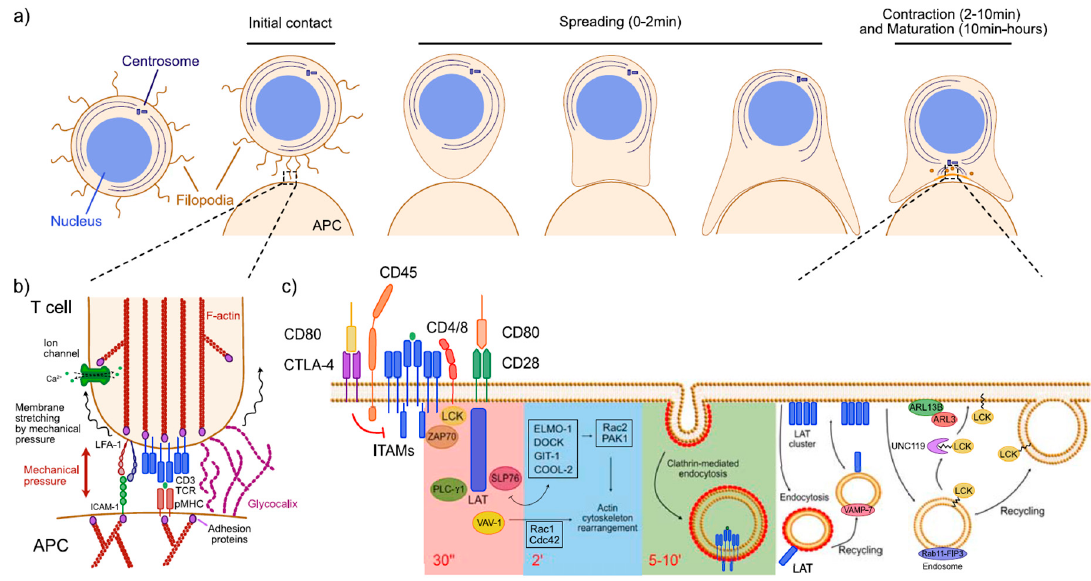
Figure 1. Temporal regulation of signaling during early T cell activation. ( a ) The schematic shows the stages of early T cell activation and immunological synapse formation (adapted from [19]). T cells scan their environment via filopodia sensing. After initial contact (that occurs within seconds), the T cell spreads rapidly, increasing the area of contact between the T cell and antigen-presenting cell (APC) (which lasts up to 2 min). After full T-cell spreading, the T cell retracts, in a process that involves actin cytoskeleton rearrangement aided by adhesion proteins and proteins that mediate contractility (2–10 min). Cell contraction is accompanied by an active retrograde transport of signaling molecules from the periphery of the interaction to the center that will ultimately lead to a mature interaction and formation of the immunological synapse. ( b ) Schematic of initial contact between the T cell and APC mediatedbyfilopodia / microvilli. Filopodiaactasprimarycellsensors, concentratingintegrins, receptors, ion channels, kinases, and phosphatases in other areas of the plasma membrane. Upon contact with an APC, an array of mechanical and chemical signals involving the T cell receptor-Major Histocompatibility Complex (TCR-MHC) and the Lymphocyte function-associated antigen 1-Intercellular Adhesion Molecule 1 (LFA-1-ICAM-1) interactions (among others), rapidly lead to drastic rearrangement of the membrane and the actin cytoskeleton. The thick cellular glycocalyx might be compressed and even displaced upon contact, allowing a better access to receptors and ligands from T cell and APC, increasing the chances of encounter. The TCR is sensitive to mechanical forces that alter its sensitivity and specificity to ligand, modifying the threshold of activation. As other integrins, LFA-1 is involved in transducing mechanical information into the cell through adhesion proteins, leading to changes in the actin cytoskeleton. Mechanical forces also determine the lifetime bond of LFA-1 and its ligand, leading to interactions of di ff erent strength and duration. Mechanosensitive ion channels or transient receptor potential proteins detect stretching and changes in tension in the near membrane altering their conformation and modifying the transit of ions that will initiate signaling cascades involved in actin cytoskeleton rearrangement and T cell activation. ( c ) The schematic shows the kinetics of TCR,